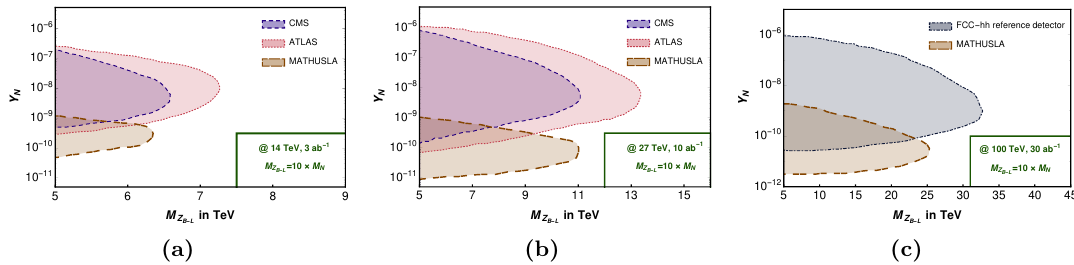
Figure 13. Limits obtained via the displaced decays of RHNs to 2 ‘ +4 j final state and is presented in Y versus M plane at 95% CL, where M = 10 M . The probable regions are shown for N Z B − L Z B − L N different centre of mass energies, i.e. 14 TeV, 27 TeV and 100 TeV with the integrated luminosities of 3, 10 and 30 ab − 1 , respectively. The purple, pink, grey and light brown colours depict the reaches for CMS, ATLAS, FCC-hh reference detector and MATHUSLA, respectively.